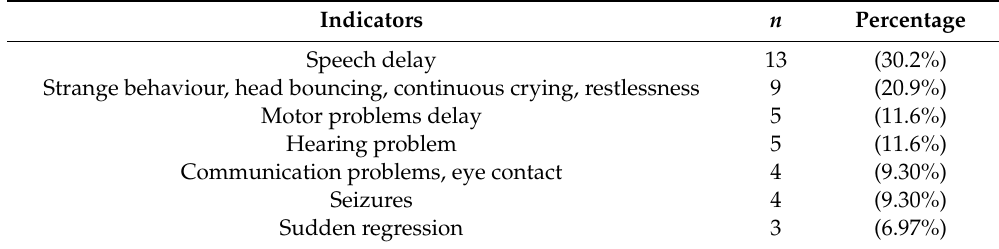
Table 4. The child problem indicators from the parental